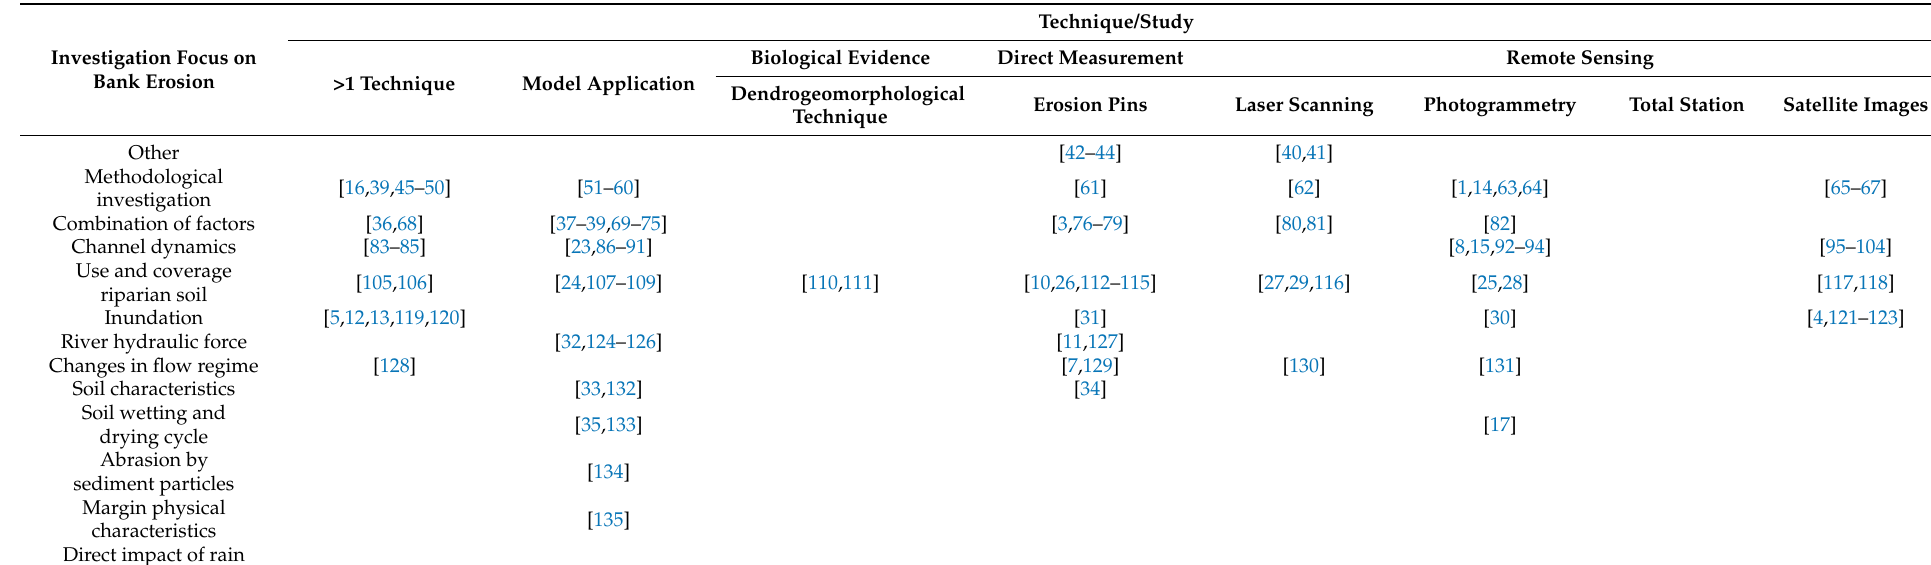
Table 3. Techniques used to quantify and estimate margin erosion, as well as the focus of each